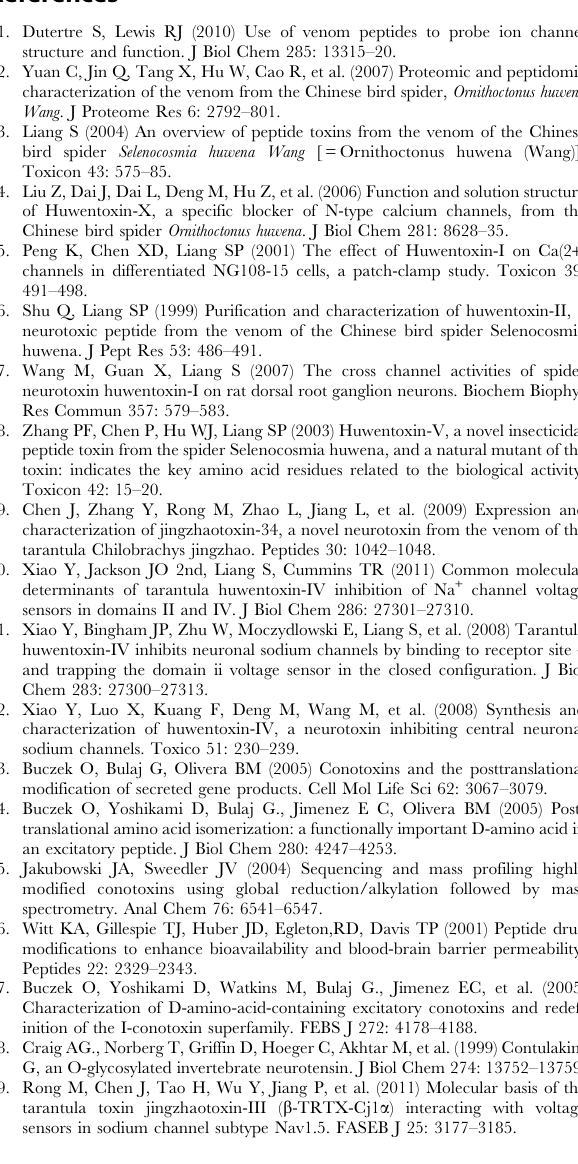
Figure S1 N-terminal sequences of HWTX-IV were determined by Endman degradation. Residue signals were detected in each panel and six residues were identified. (TIF) Figure S2 Sequences of mHWTX-IV were determined by Endman degradation. No obvious signal of amino acid residue was observed in the panel (residue 1-residue